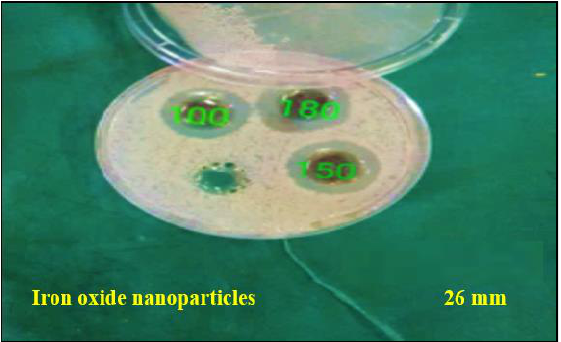
Fig. 3. Effects of iron oxide nanoparticles on P.